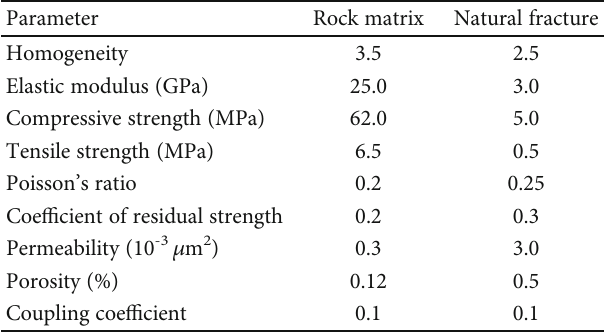
Table 2: Mechanical parameters in the numerical